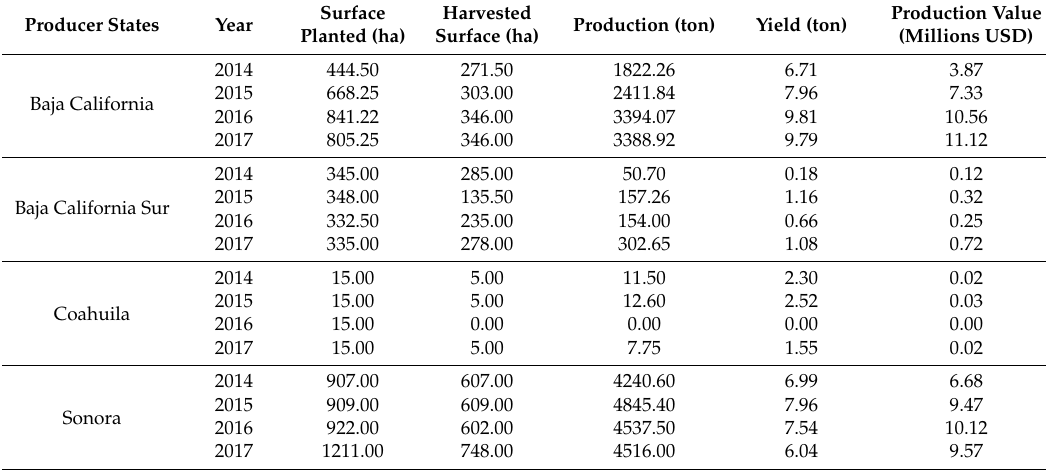
Table 1. Statistical and economic summary of date production in commercial plantations of Mexico in the period from 2014 to